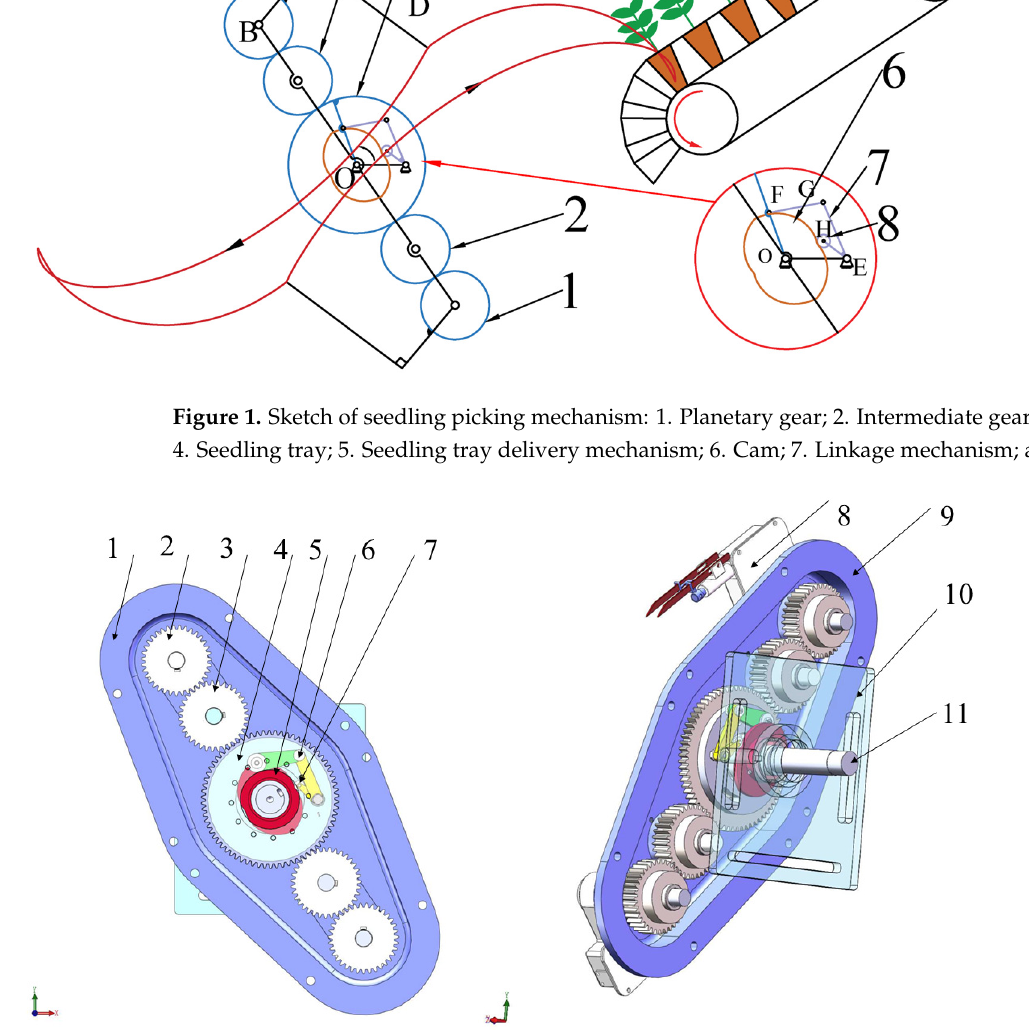
Figure 3. Sketch of seedling picking arm: 1. Seedling pushing cam; 2. Fork; 3. Seedling pushing rod; spring; 4. Spring; 5. Seedling picking arm housing; 6. Seedling pushing plate; 7. Seedling picking needle; and 8. Seedling picking needle